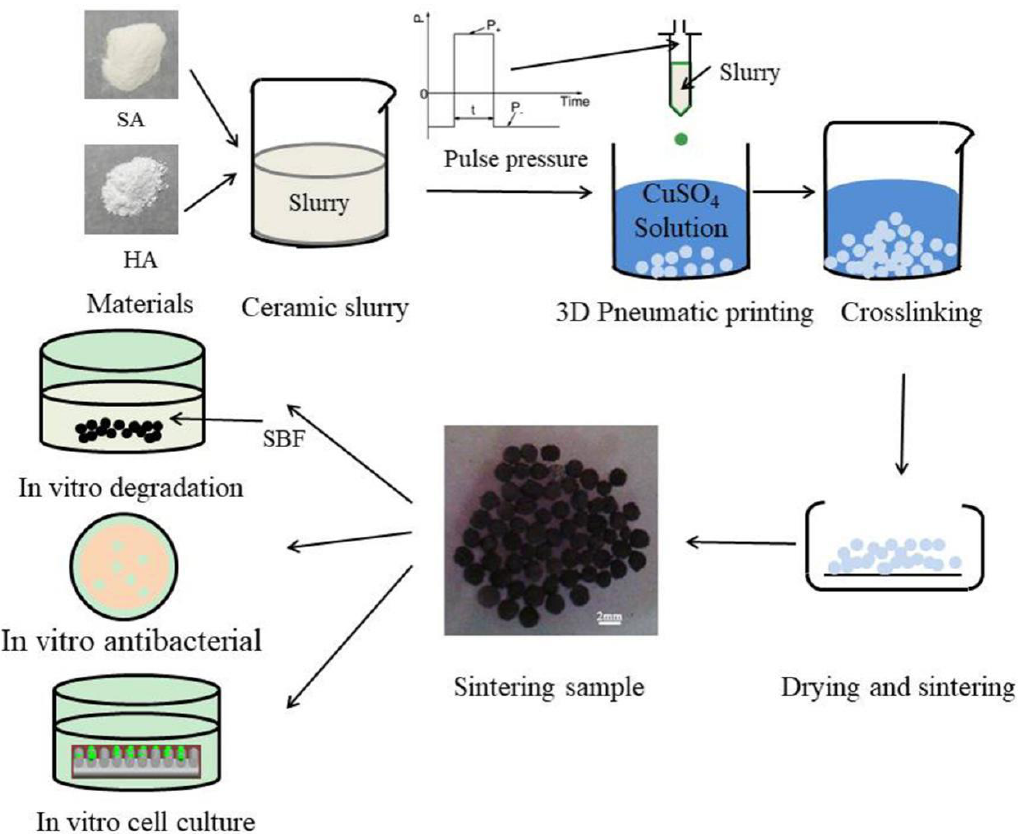
Figure 1. Schematic representation of the preparation protocol for the Cu-doped hydroxyapatite (HA) macrobeads.